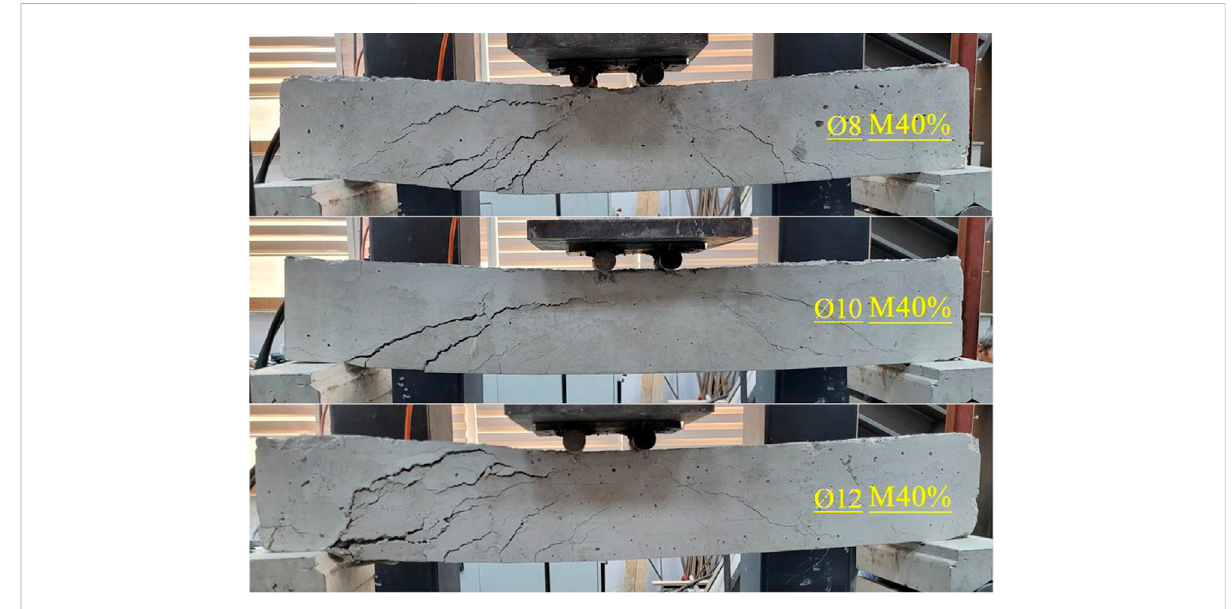
FIGURE 12 Fracture and bending attitude of RCB for V 8-M40%, V 10-M40%, V